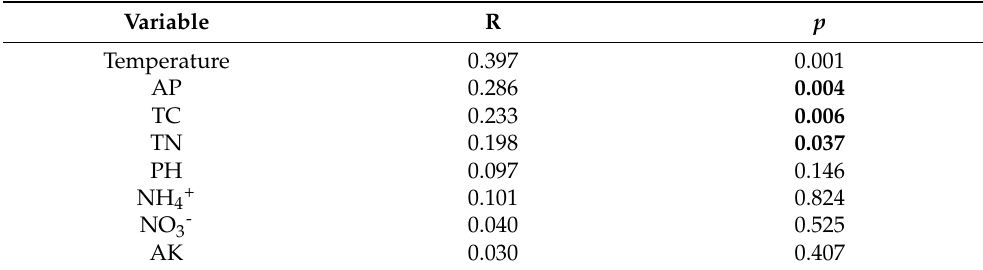
Figure 4. Canonical correlation analysis (CCA) ordination diagrams of soil bacterial communities and soil variables defined by the first and second axes. Table 2. Statistical results of Mantel tests evaluating the relation between soil environmental variables and bacterial community structure. Significant effects ( p < 0.05) are shown in bold.